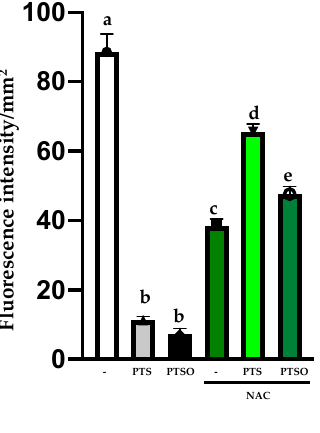
Figure 3. ( A ) Cytotoxicity of PTS and PTSO on MCF-7 and T-84 cells in absence or presence of NAC 5 mM. The concentration of PTS and PTSO was equal to IC 50 and all cells were induced for 72 h. The histogram depicts means ± SD of six determinations. **** = p < 0.0001. ( B ). Effect of PTS and PTSO on ROS production detected by DCFH-DA staining (magnification 25× and zoom 1.5×) in MCF-7 cells. The relative fluorescence intensity was expressed as the mean ± SD. Different letter between columns indicates significant differences at p < 0.05.